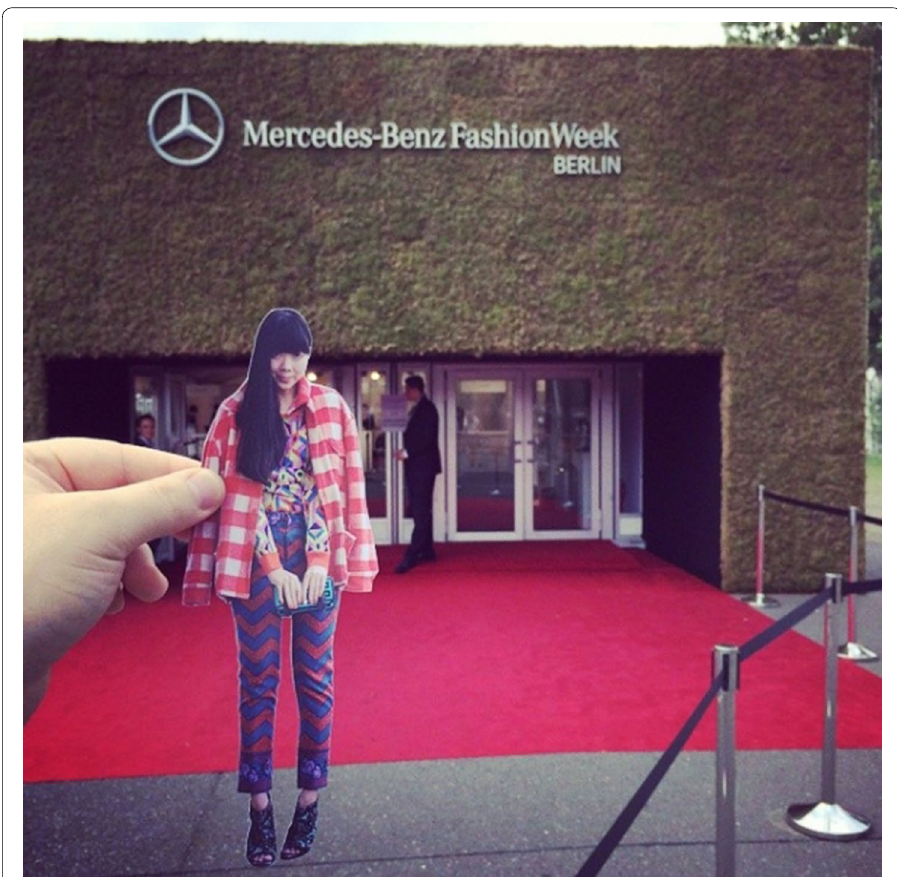
Fig. 11 Travelling with Kalen Holloman’s hand to MBfashionweek. https ://www.insta gram.com/p/qT2DO sKaq_/. Accessed 22 September